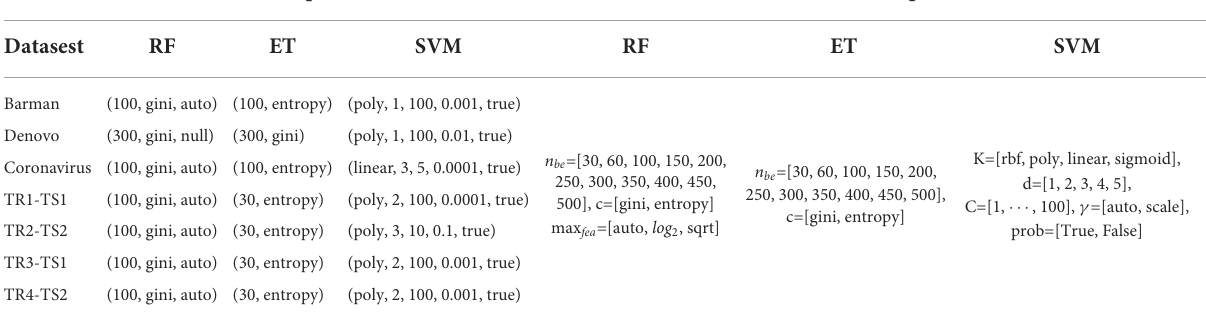
TABLE 1 Grid search parameters along with optimal values for 3 different machine learning classifiers used for virus-host protein-protein interaction prediction. Selected parameters Grid search